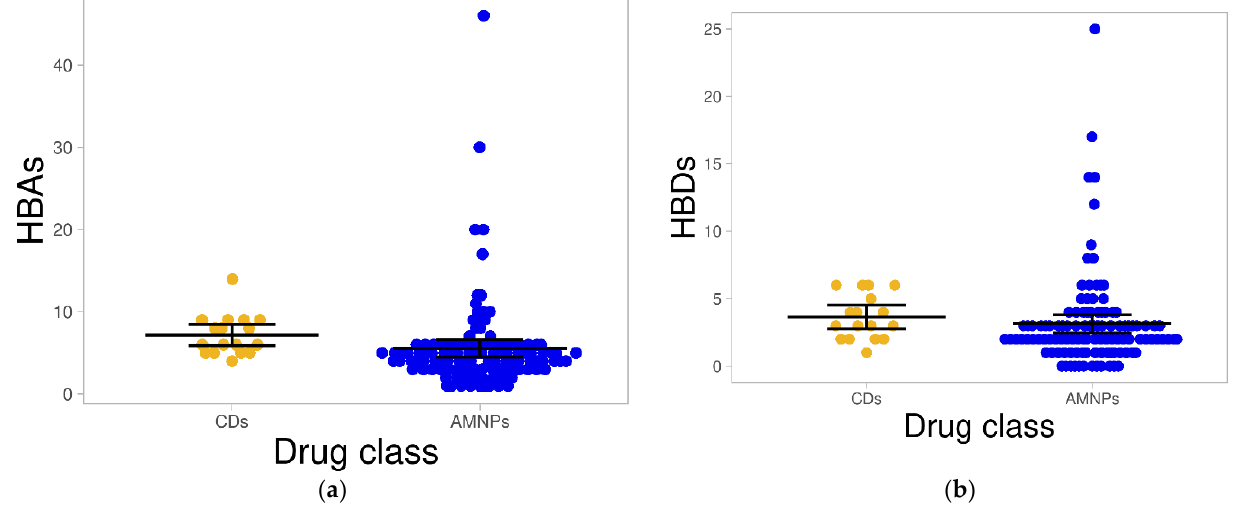
Figure 3. Distribution of hydrogen bonds for both AMNPs and CDs. ( a , b ) presents swarm plots showing the distribution of HBAs and HBDs, respectively, for both datasets. The black bars in both figures show a 95% confidence interval in the distribution.